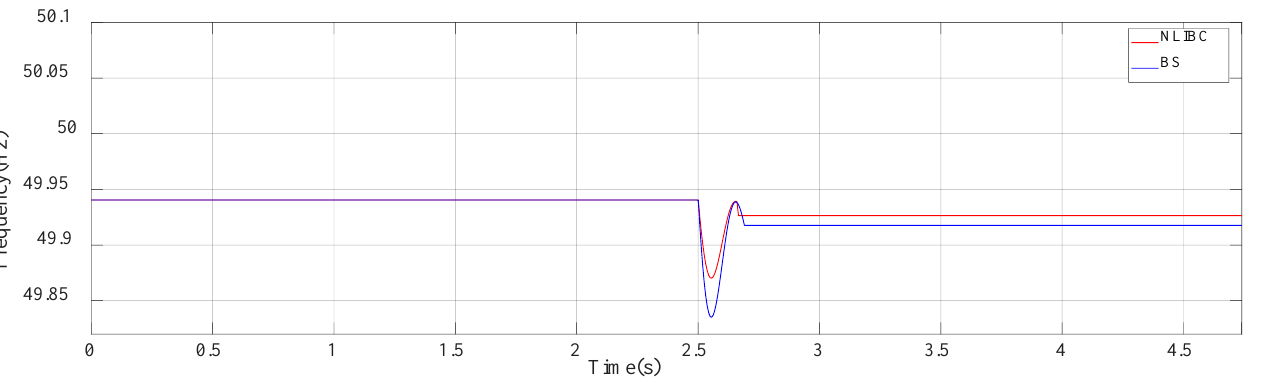
Figure 28. Comparison of NLIBC and backstepping (BS) for voltage regulation zoomed in view.